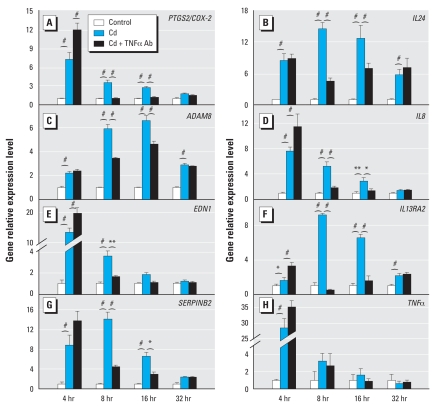
Validation of microarray data and investigation of the role of TNF in Cd-treated NPrEC cells. Real-time RT-PCR confirmed the up-regulation of 7 of the 11 TNF-related genes inferred by IPA. It also demonstrated a transient increase in TNF mRNA expression following Cd treatment. Each time point represents the mean value of quadruplicates ± SD. Two-way ANOVA compared Cd-treated group with control and Cd + Ab group, respectively.*p < 0.05. **p < 0.01. #p < 0.001.